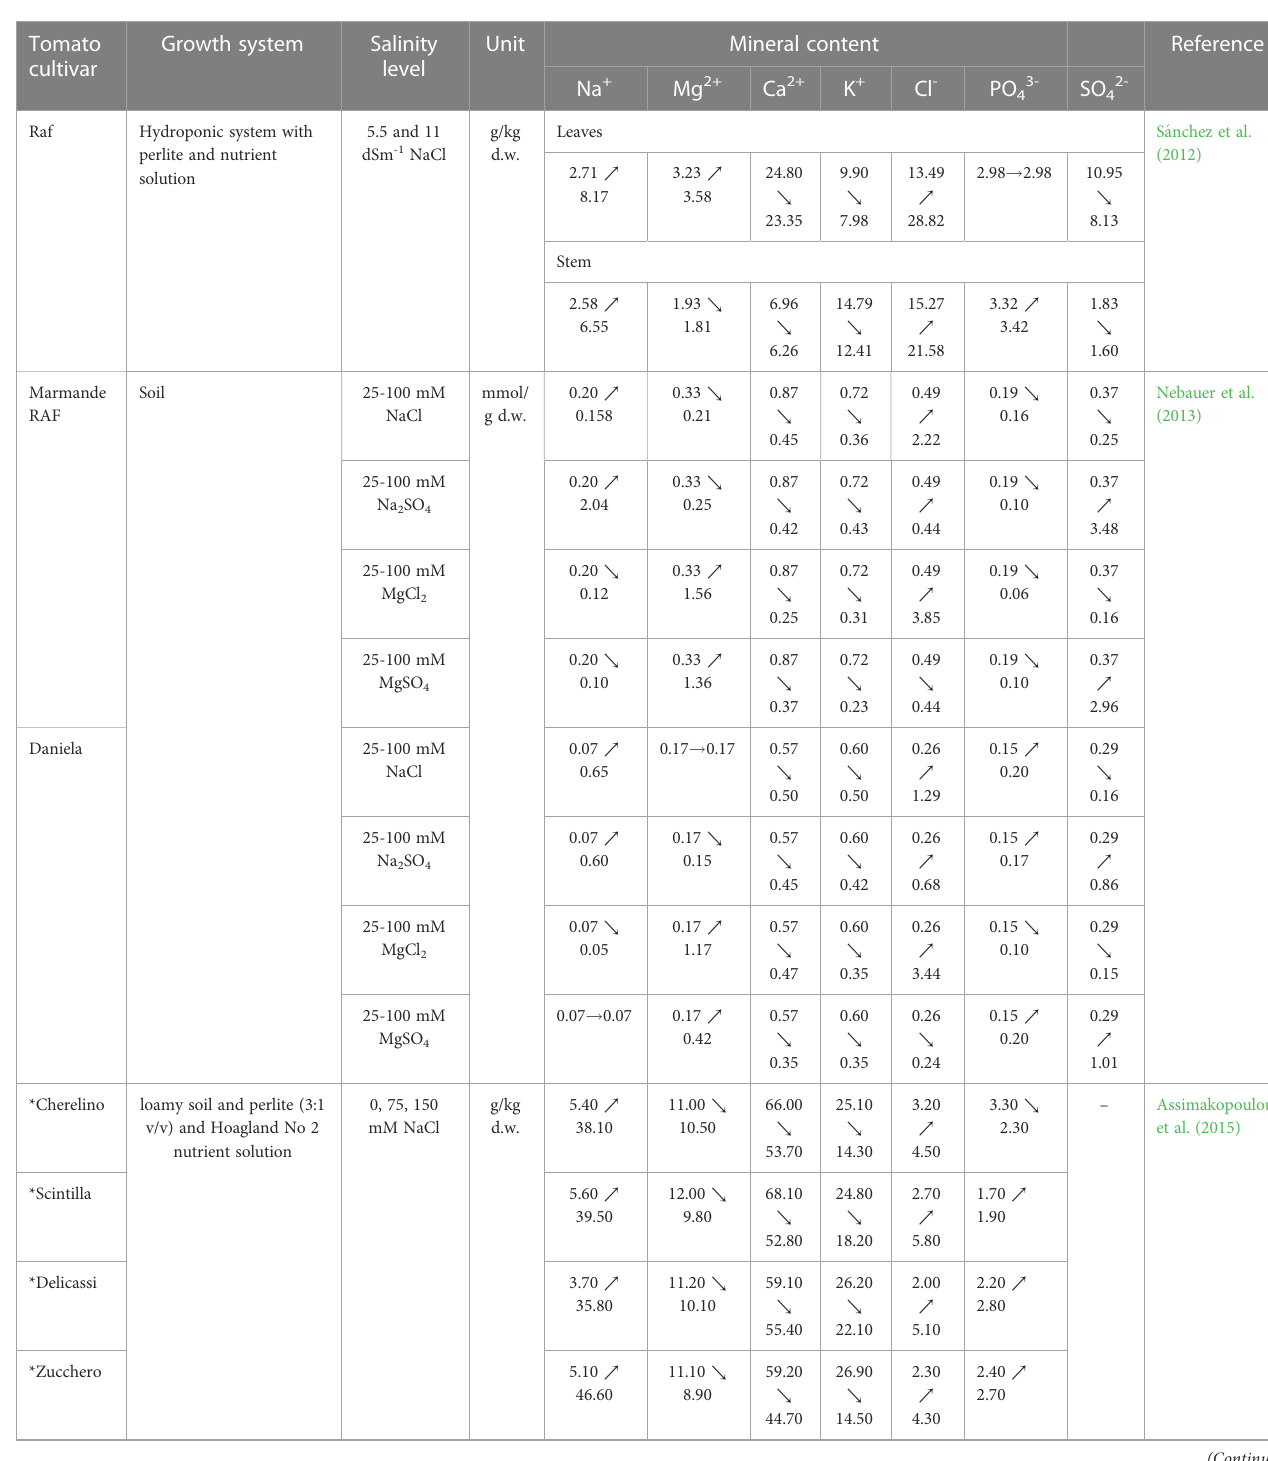
TABLE 3 Mineral accumulation in tomato leaves under salinity